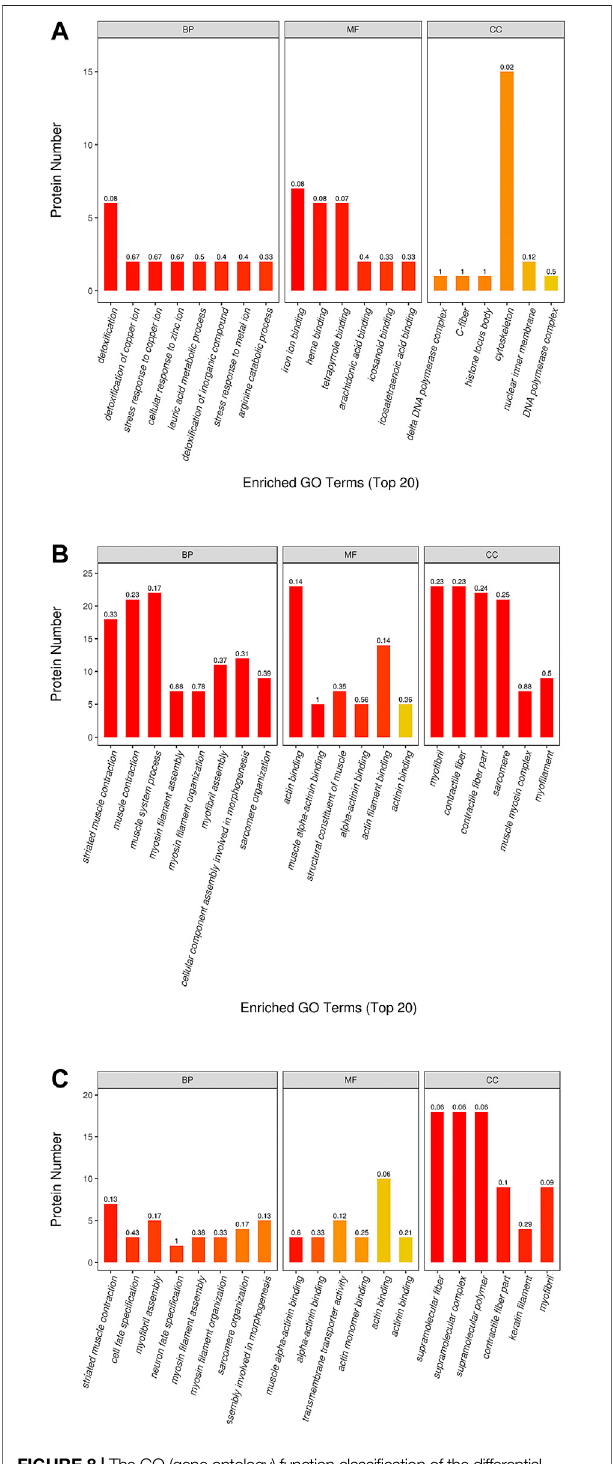
FIGURE 8 | The GO (gene ontology) function classi fi cation of the differential protein identi fi ed by the TMT-based proteomics. The GO enrichment analysis of proteins from the liver samples was performed according to the BP (biological process), MF (molecular function) and CC (cellular component). The comparisonbetweenthe (A) blankgroupandmodelgroup,betweenthe (B) ULRA group and model group, between the (C) YF group and model group was performed.ULRA,unprocessedlateralrootof Aconitumcarmichaelii ;YF,Yinfupian.